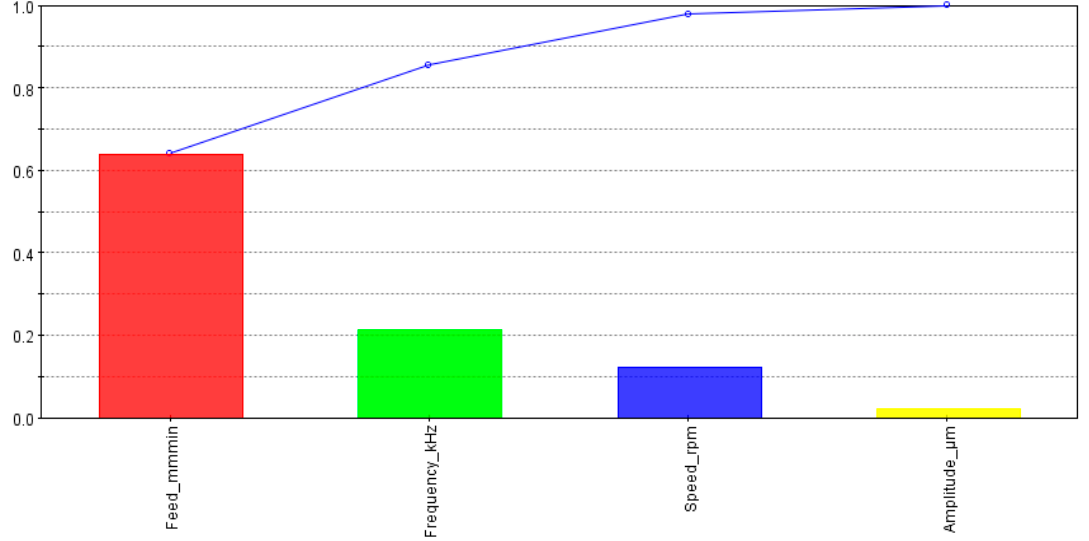
Figure 10. E ff ects of input parameters on Figure 10. Effects of input parameters on taperness. Figure 10. Effects of input parameters on taperness.